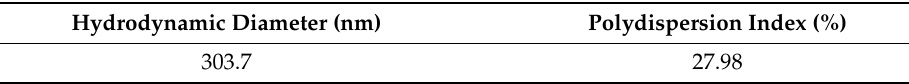
Table 5. SSA and VSSA of the dried AuNPs in a PVP matrix.